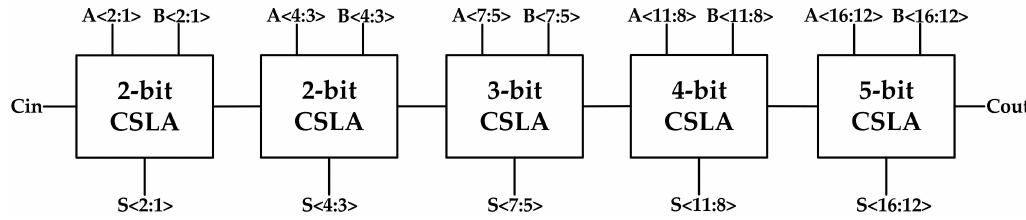
Figure 4. Architecture of a 16 bit multi-stage